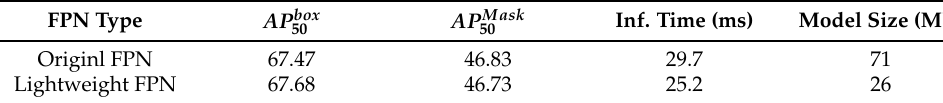
Table 6. Ablation study of lightweight FPN and original FPN.